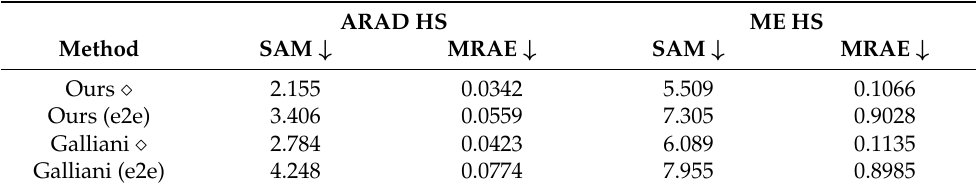
Table 1. Comparison of learning methods. (cid:5) indicates learning spectral similarity, and e2e indicates end-to-end